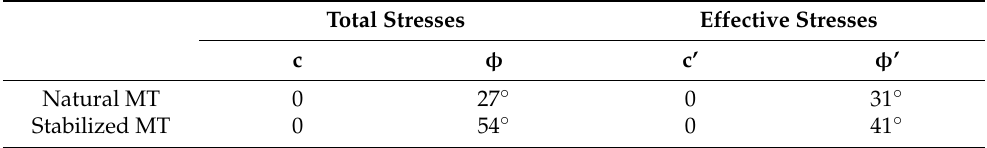
Figure 21. Failure envelopes of the mine tailing in residual deviatoric stresses (stabilized specimens).